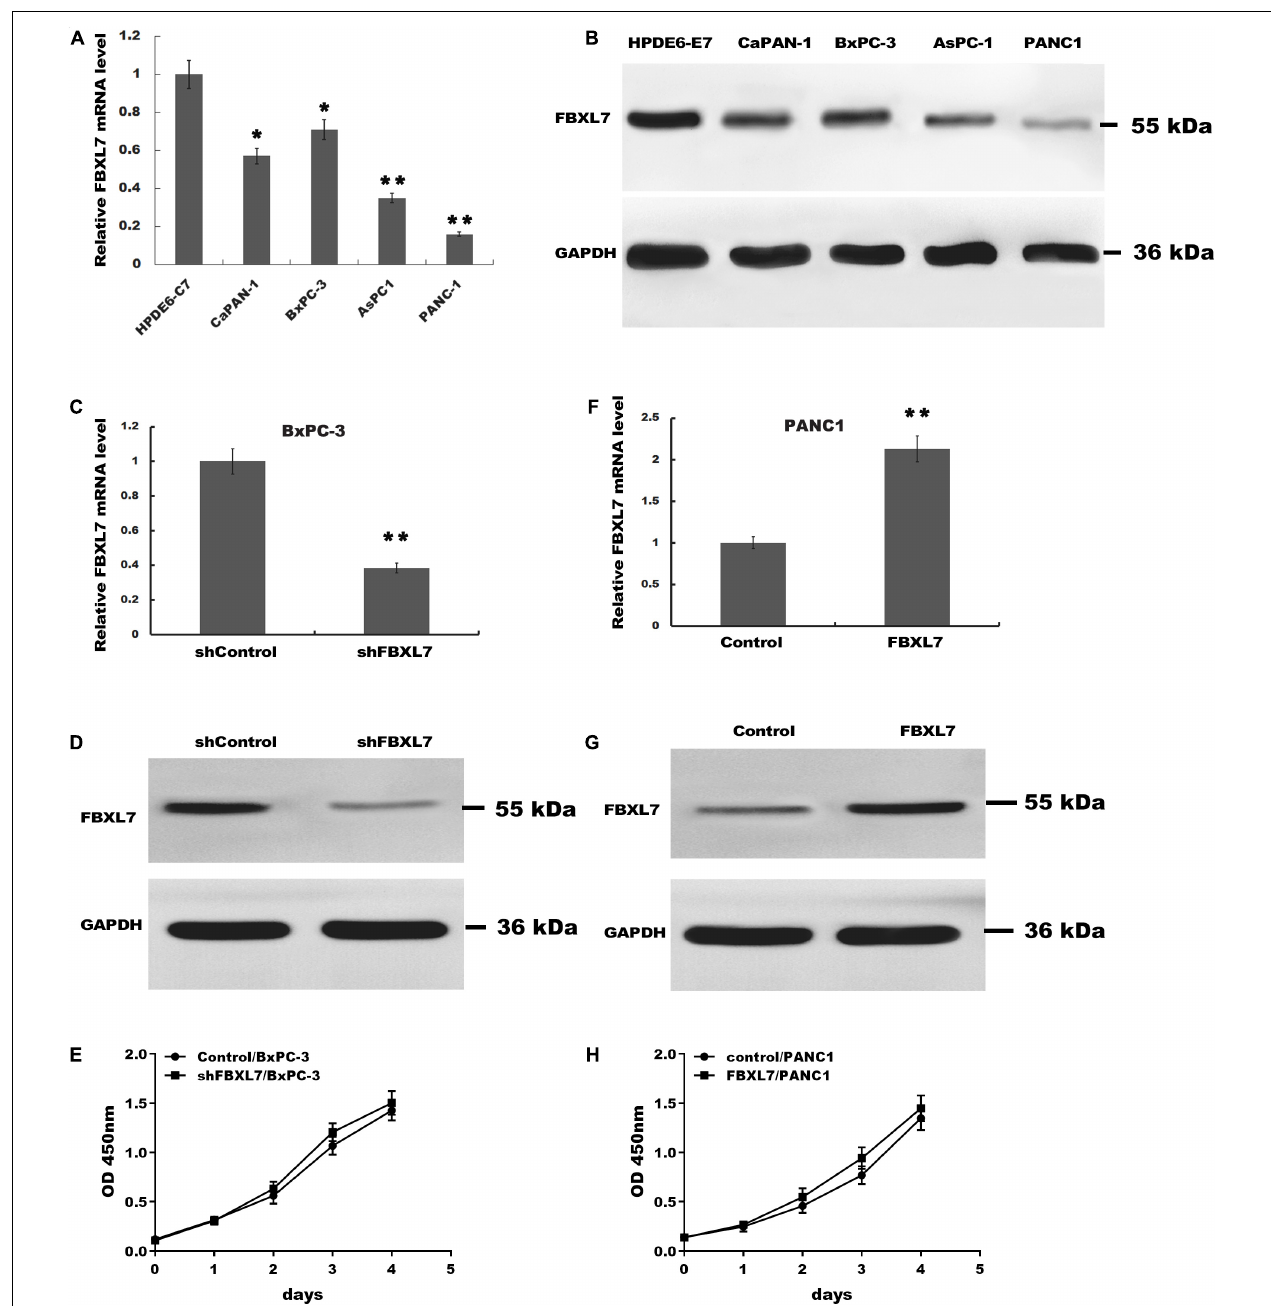
FIGURE 2 | The proliferation of BxPC-3 and PANC-1 cells was not significantly altered after transfected with shFBXL7 or FBXL7. (A,B) The expression of FBXL7 mRNA in PCa cell lines (HPDE6-C7, CaPAN-1, BxPC-3, AsPC1, and PANC-1) were detected by RT-qPCR (A) and Western blot (B) analysis. (C,D) The expression of FBXL7 mRNA and protein were detected by RT-qPCR and Western blot analysis in stable FBXL7-silenced BxPC-3 cells. (E) The proliferation of FBXL7-silenced BxPC-3 cells was analyzed by CCK8 assay. (F,G) The expression of FBXL7 mRNA and protein were detected by RT-qPCR (F) and Western blot analysis (G) in FBXL7-overexpressing PANC1 cells. (H) The proliferation of stable FBXL7-overexpressing PANC1 cells was analyzed by CCK8 assay. The figure (A,C,F) Data represent means ± SD of three independent experiments with significance determined by two-tailed Student’s t -test * P < 0.05, ** P <